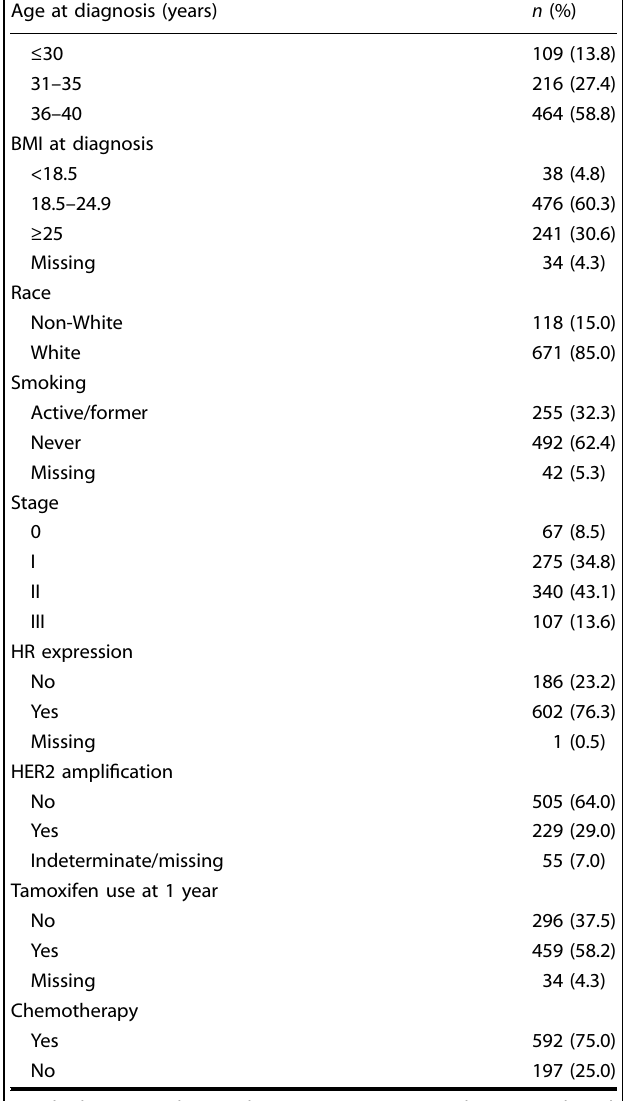
Table 1. Patient, disease, and treatment